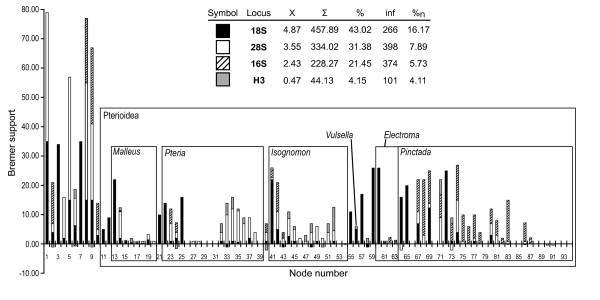
Partitioned Bremer support (PBrS) analysis. The histogram shows proportional support of each locus for all the nodes (as labeled in Figure 2). The table above the histogram summarizes the PBrS statistics for each locus. Χ, the average Bremer support; Σ, the total Bremer support; %, the percentage of the cumulative Bremer support; %n, percent normalized by the number of parsimony informative characters.